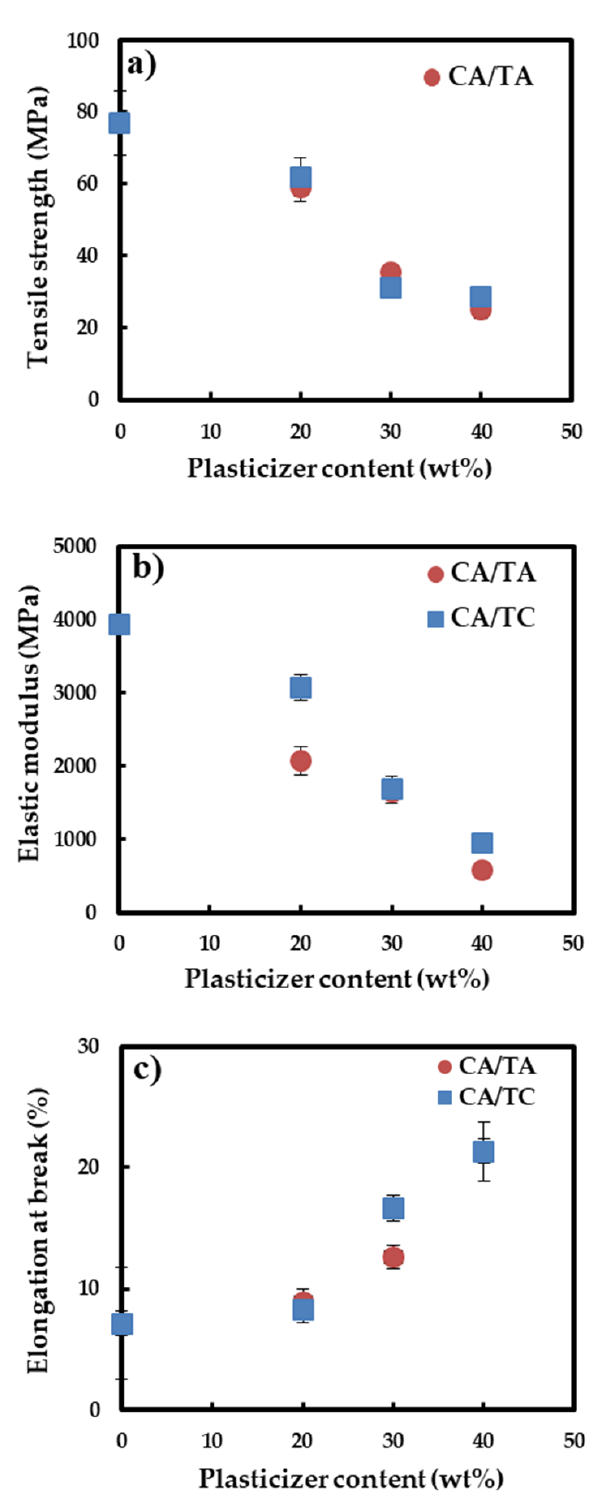
Figure 1. Tensile strength ( a ), elastic modulus ( b ), and elongation at break ( c ) of CA with TA and TC as a plasticizer in different ratios.